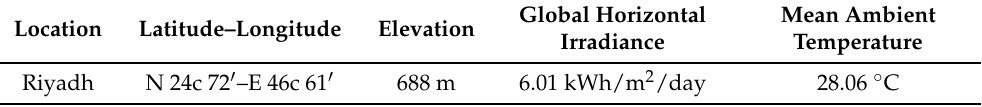
Table 2. Annual mean air temperature and global horizontal irradiance for Riyadh, Saudi